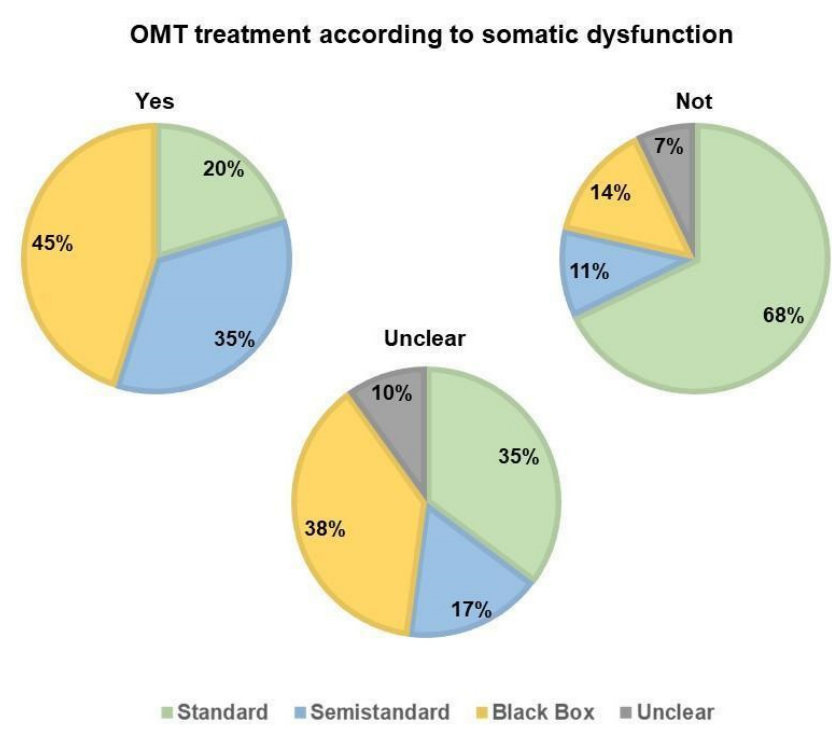
Figure 5. OMT treatment (standard, semistandard, black box or unclear) according to somatic dys- function across the studies included in the review. Yes: OMT treatment was based on somatic dys- function; Not: OMT treatment was not based on somatic dysfunction; Unclear: it was not defined if OMT treatment was based on somatic dysfunction. OMT = Osteopathic Manipulative